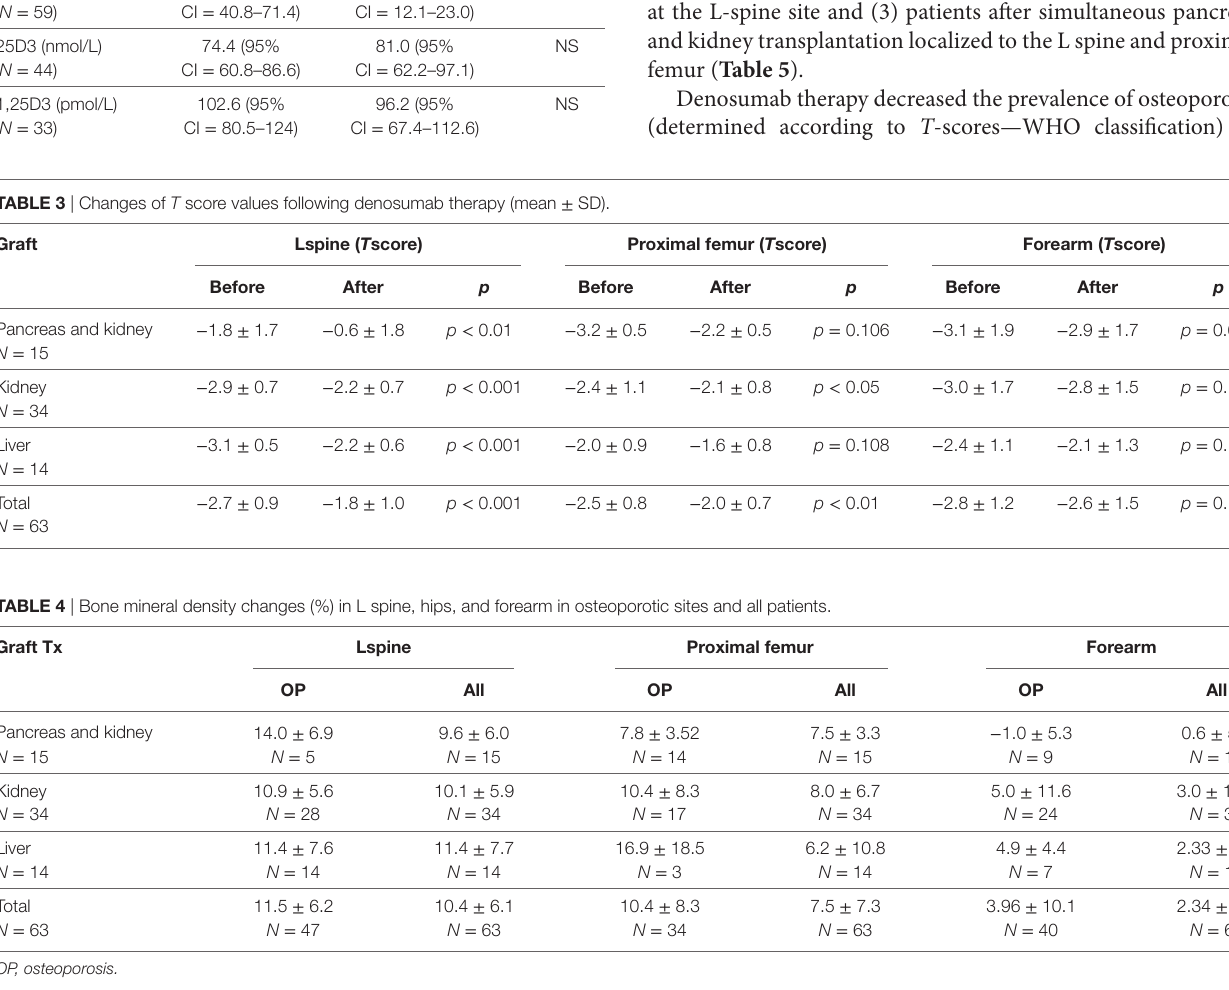
( Table 4 ). The best responders to denosumab therapy were as follows: (1) patients after liver transplantation localized to